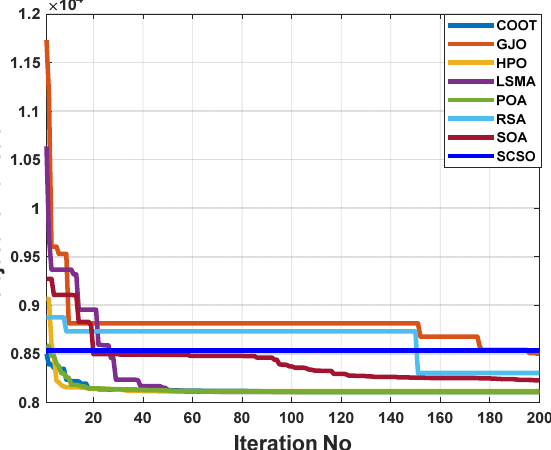
Figure 16. The convergence characteristics of POA and other compared algorithms for case 5 in a standard IEEE 14-bus test system.